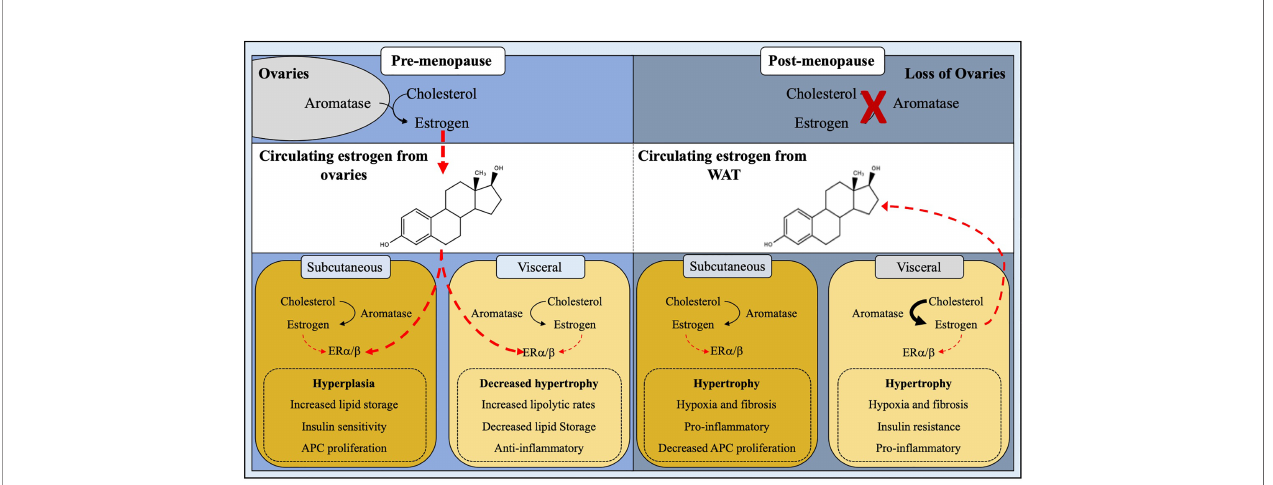
FIGURE 2 | Site-speci fi c regulation of adipose tissue by estrogen. White adipose tissue homeostasis and expansion is in fl uenced by estrogen. In pre-menopausal females, estrogen produced by the ovaries plays a major role in ER a / b signaling thus downregulating androgen receptors, leading to hyperplastic subcutaneous WAT expansion and decreased visceral adipogenesis. Post-menopausal women have a ∼ 95% reduction in circulating estrogen levels due to cessation of ovarian function, resulting in a stunted ER a / b activation, thus giving rise to metabolically unhealthy hypertrophic WAT